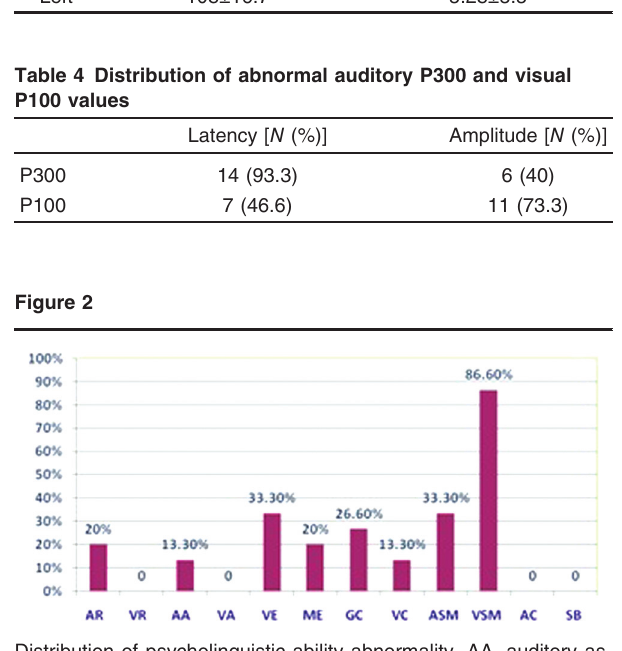
Distribution of psycholinguistic ability abnormality. AA, auditory as- sociation; AC, auditory closure; AR, auditory reception; ASM, audi- tory sequential memory; GC, grammatical closure; ME, Mannual expression; SB, sound blending; VA, visual association; VC, visual closure; VE, verbal expression; VR, visual reception; VSM, visual